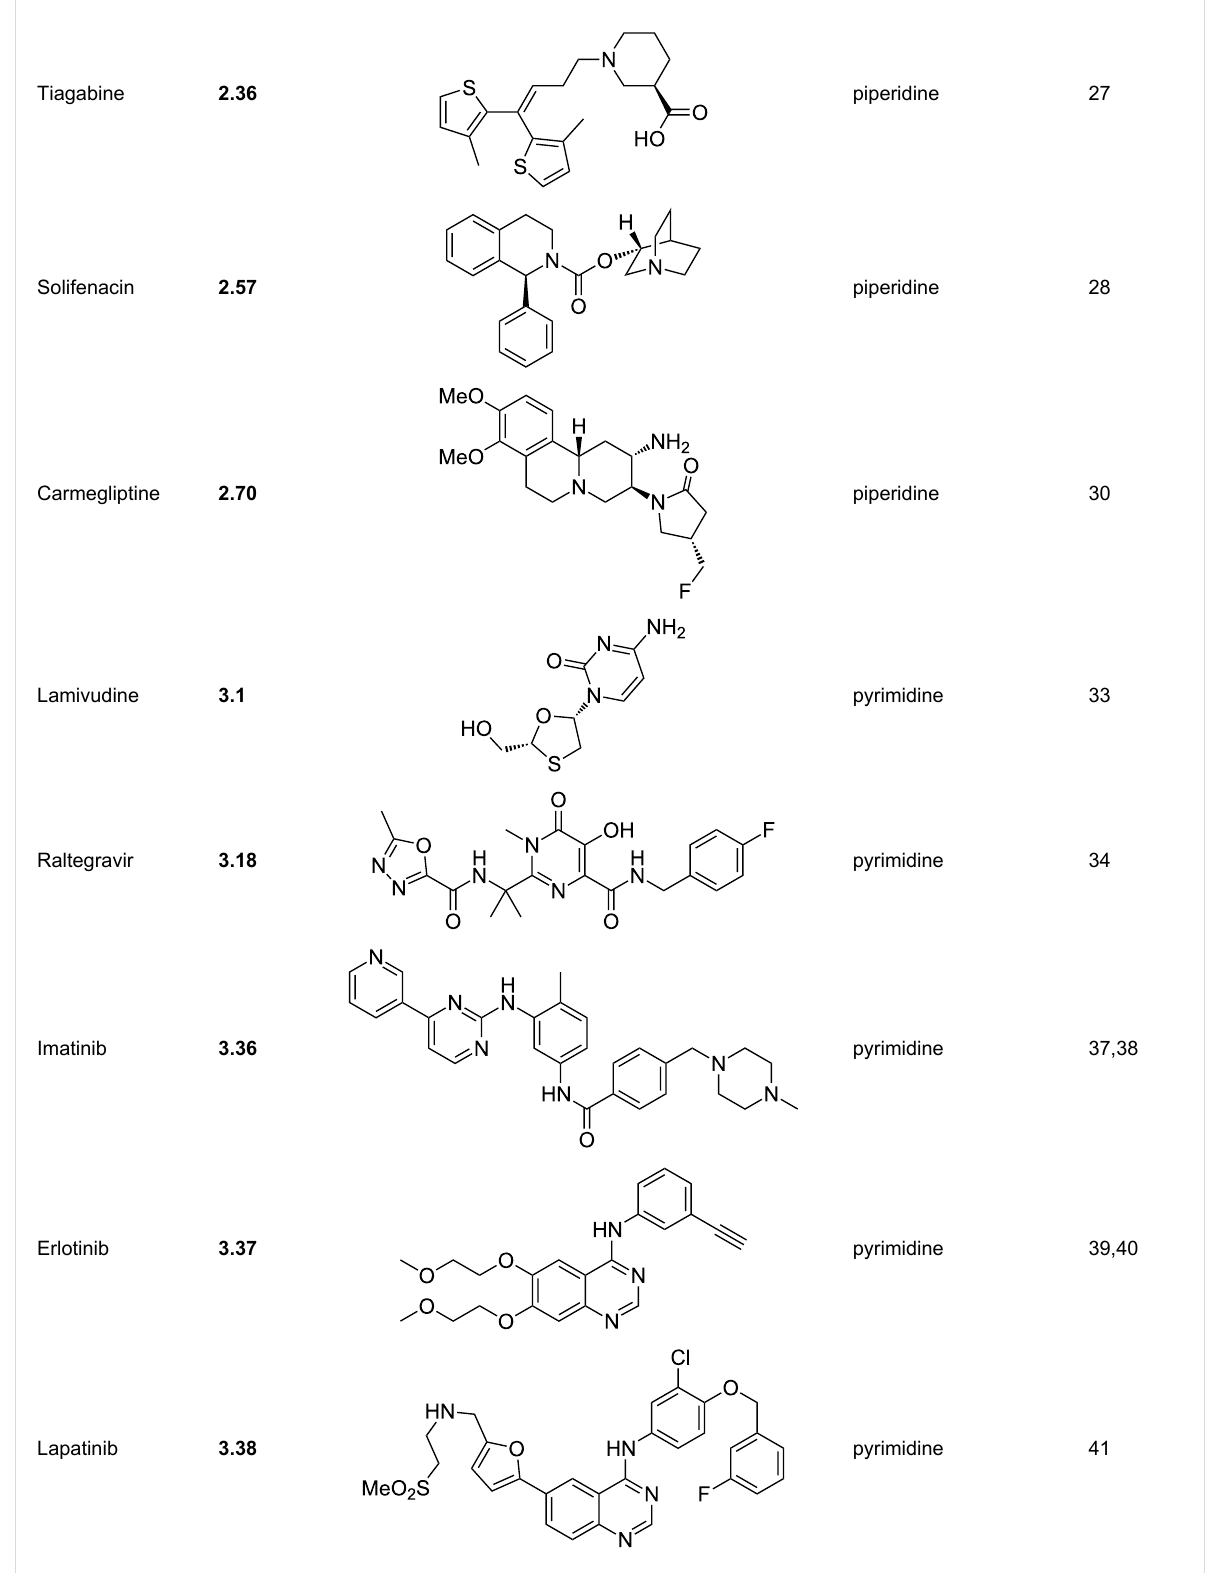
Table 1: Chemical structures of the heterocyclic compounds discussed in this review. (continued)